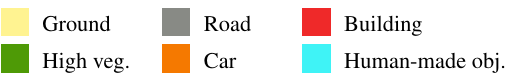
Figure 3. Qualitative results obtained with our approach on the Ankeny dataset, using the other two datasets for training. We used neighbor color features within a 0.6-meter radius neighbor- hood and the Gradient Boosted Trees classifier. Incorporating color information into the classifier yields a significant boost in accuracy, particularly for the road and high vegetation classes.